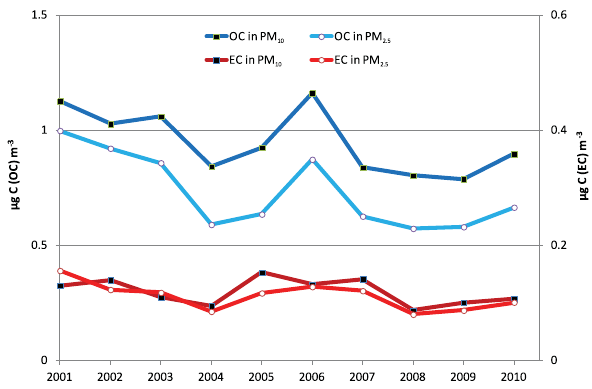
Fig. 6. Time series of PM 2 . 5 (left) and PM 10 (right) at selected EMEP sites.